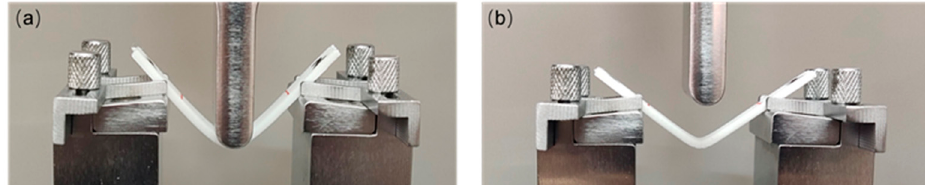
Figure 21. ( a ) External force is applied to the sample to a displacement of 15 mm. ( b ) 10 min later, the elastic deformation of the sample is restored after the external force is removed.